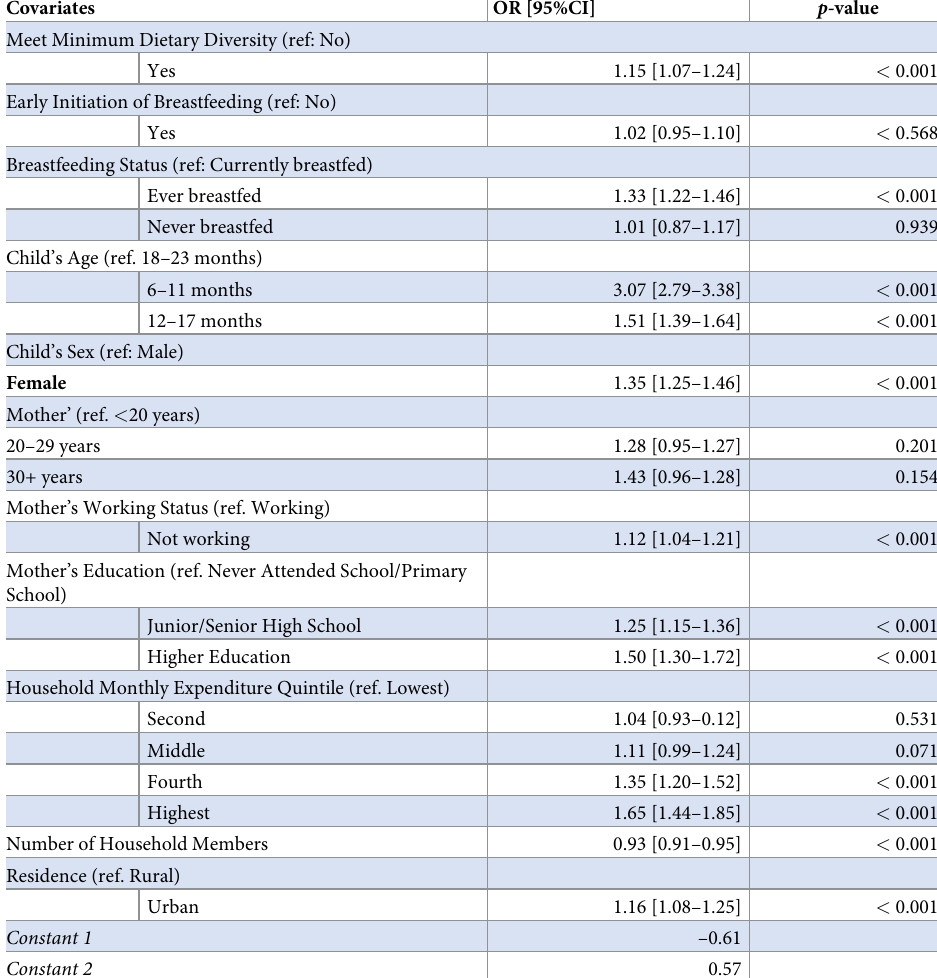
Table 4. Odds Ratio (OR) of the ordinal logistic regression RISKESDAS 2018. Covariates OR [95%CI] p-